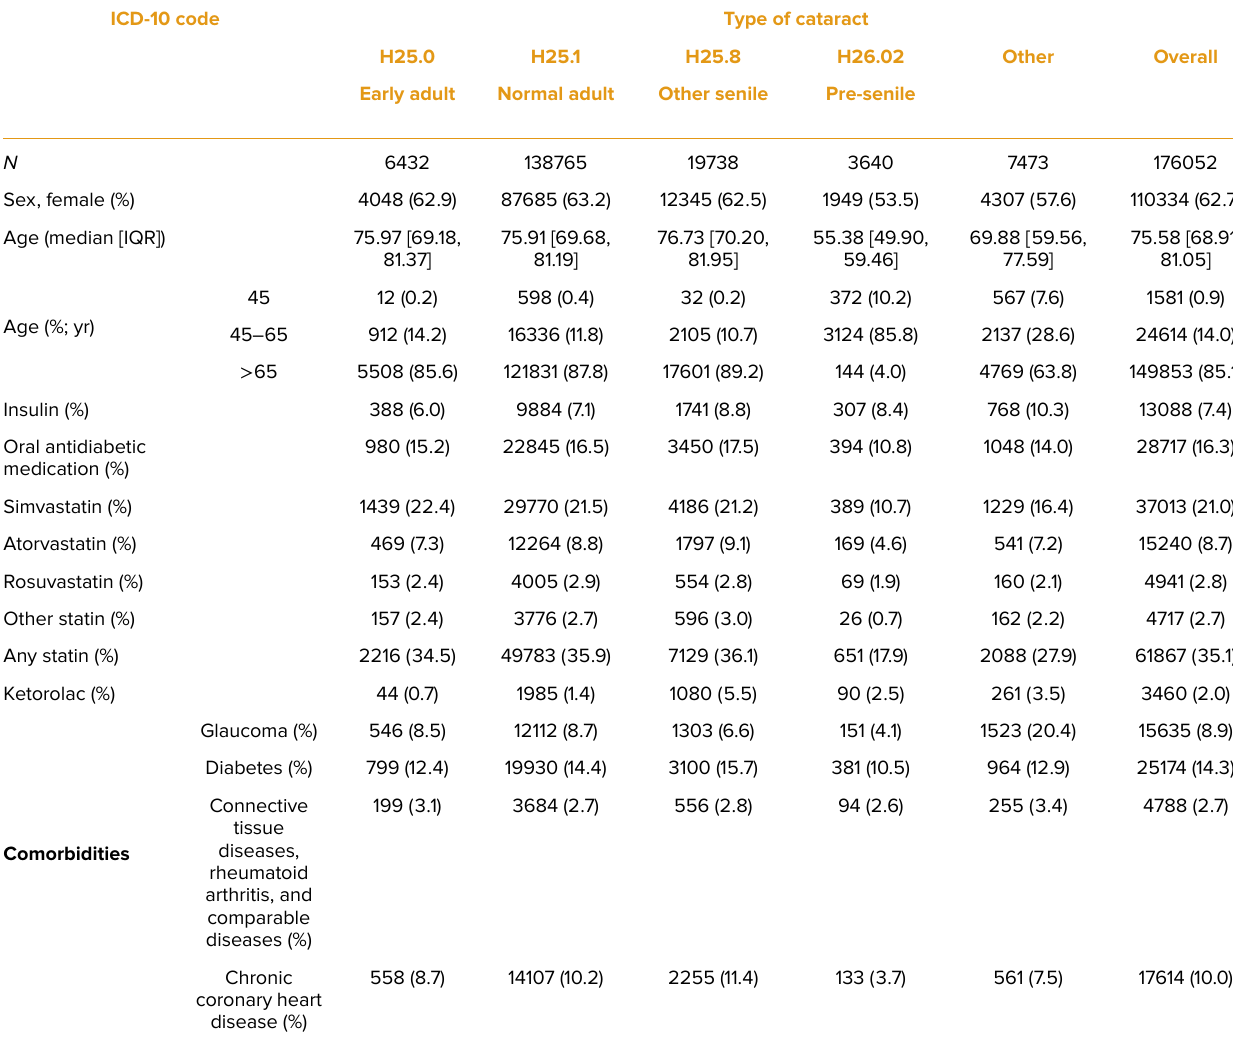
Table 1. Basic characteristics of Finnish study cohort ( n = 176 052). ICD-10